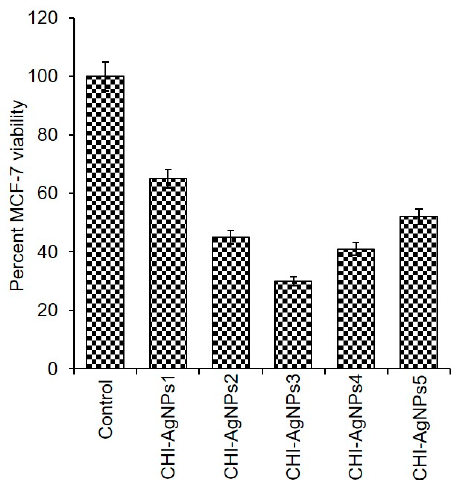
Figure 6. Percent viability of newly developed CHI-AgNPs conjugates against breast cancer cell line, Figure 6 . Percent viability of newly developed CHI ‒ AgNPs conjugates against breast cancer cell line, i.e., i.e., MCF-7.